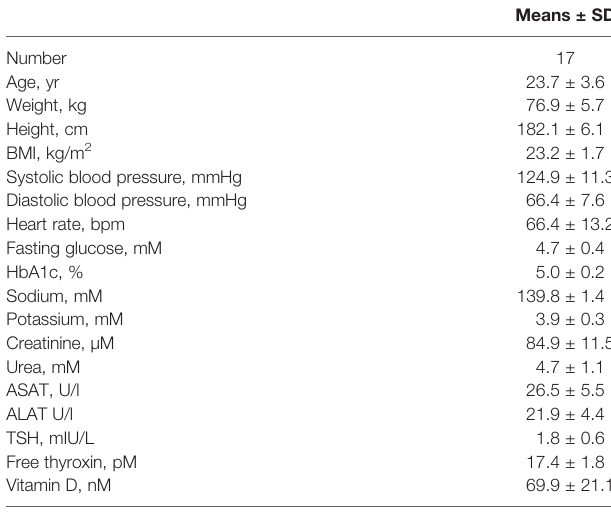
TABLE 1 | Characteristics of the study